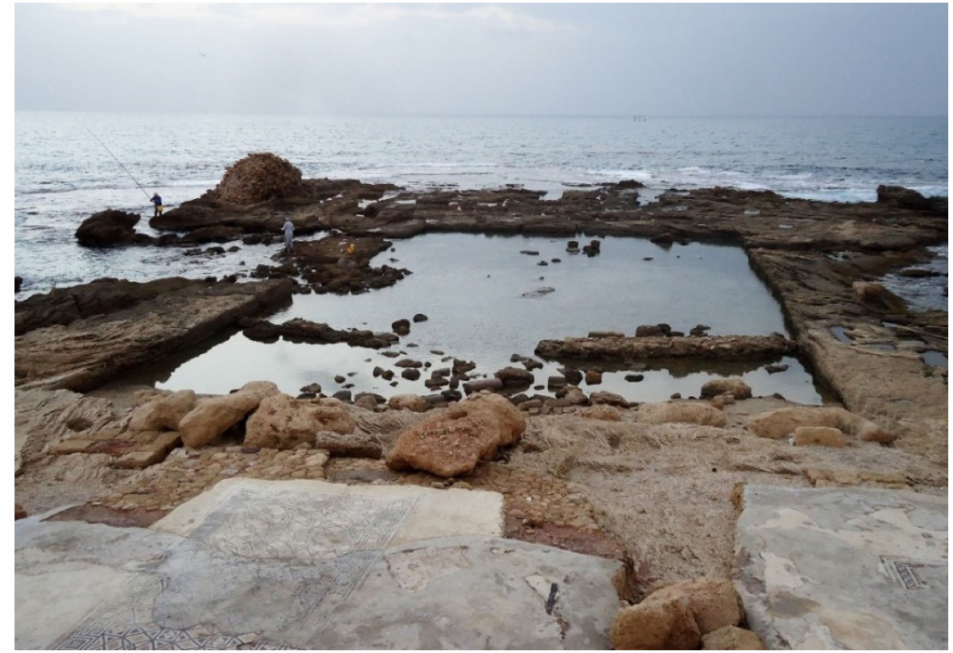
Figure 8. The rock-cut Roman pool in the reef palace, looking south (for location see Figure